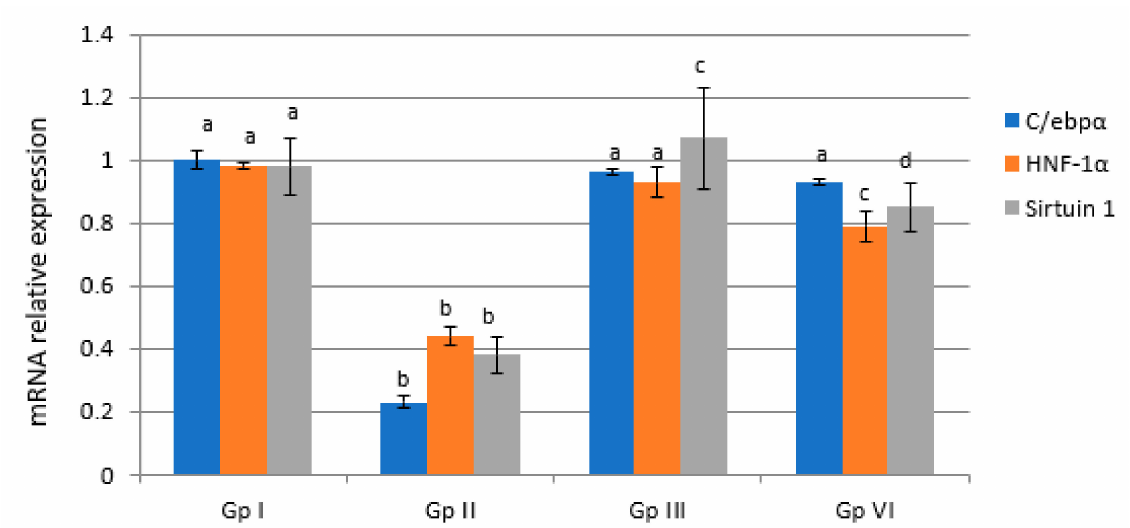
Figure 4. Effect of MESC and silymarin on the expression levels of liver C/ebp α , HNF-1 α , and sirtuin-1 genes in paracetamol-treated rats. Data are presented as fold increases with respect to control values, considering the normal control values equal to 1. Data followed by the same letter within the same parameter are not significantly different at p ≤ 0.05.